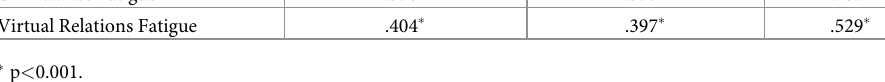
Off-Balance and Virtual Relations Fatigue dimensions share a moderate, positive, and signifi- cant correlation (r = 0.50, p < 0.001). A CFA was then run on the second subsample. Results showed that the proposed solution provided an acceptable fit to the data, CFI = 0.951, TLI = 0.934, RMSEA = 0.072 (LO90 = 0.055, HI90 = 0.089) and factor loadings ranging from 0.38 to 0.85, with median stan- dardized loading = 0.71. Table 4 shows the correlations between the two dimensions of the Online Fatigue Scale and the related measures for concurrent (TCS scale) and convergent (PSS scale) validity. Table 5 shows the results of the Rasch Analysis. The location of each item represents the estimate for the item difficulty expressed in logits; SEM is the standard error of measurement in estimation of the item difficulty; Infit and Outfit are measures of item fit. Items are sorted by difficulty parameter: a less difficult item (i.e., lower location score) indicates that the situa- tion described in the item is more frequent and more experienced by the respondents. On the other hand, a more difficult item (i.e., higher location score) indicates that the situation described in the item is less frequent and less experienced by the respondents. The item statis- tics ranged from .666 to 1.269 for the infit statistic and from .653 to 1.354 for the outfit statistic. These values indicate an acceptable fit of the Rasch Model. The different choice of scoring between Off-Balance and Virtual Relations Fatigue subscales was due to the fact that the items included in the Virtual Relations Fatigue subscale were more difficult than the Off-Balance Fatigue items. Specifically, the least difficult items (i.e., those related to the most frequently experienced situations) according to the results of the Rasch Model were those included in the Off-Balance Fatigue subscale (i.e., items 1, 2, 3, 4, 5, 6, 10). On the other hand, the most difficult items (i.e., those related to the least frequently experi- enced situations) were those included in the Virtual Relations Fatigue subscale (i.e., items 7, 8, 9, 11). Hence the reason for making different scorings for each subscale. This is also